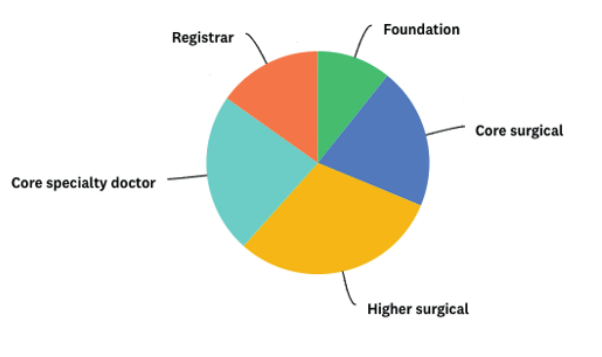
Figure 5. ‘Have you managed any patients with posterior